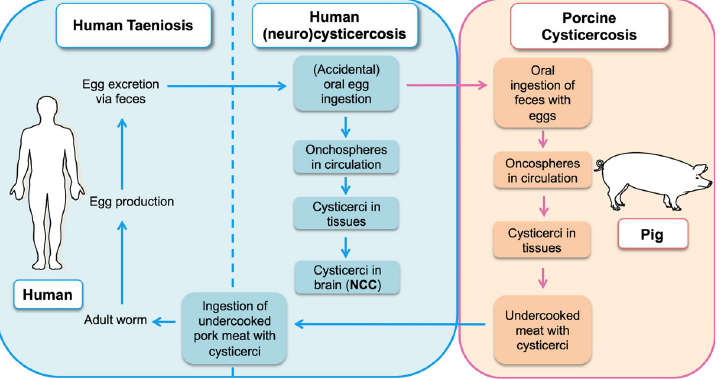
Fig 1. Schematic diagram of T . solium infection showing the different steps of human and porcine cysticercosis including human NCC. NCC,